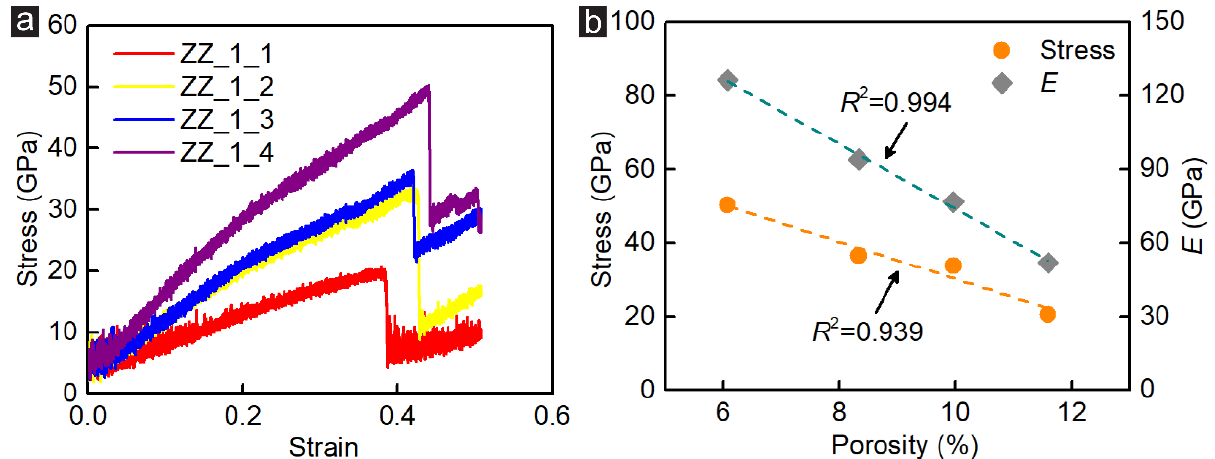
Figure 2. ( a ) The stress-strain curves of the zigzag-incised GK specimens under shear loading simulation; ( b ) The coefficient of stress and shear modulus versus the porosity of GK membrane in Group_1.